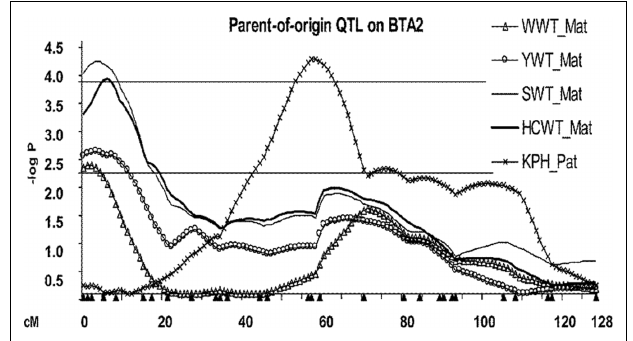
FIGURE 2 | Profile of POE–QTL on BTA2 for growth and carcass traits (WWT, weaning weight;YWT, yearling weight; SWT, slaughter weight; HCWT, hot carcass weight; KPH, percentage of kidney, pelvic, and heart fat relative to carcass weight). The negative of the logarithm (base 10) of the comparison-wise significance value is shown for the inferred QTL models against the chromosomal position. Upper and lower lines indicate the average –log 10 values of 2.24 and 3.85 across models, traits, and chromosomes for the detected QTL, representing 5% chromosome and 5% genome-wise significance thresholds, respectively. Filled triangles under the X -axis are marker positions. Mat, maternally expressed. Pat, paternally